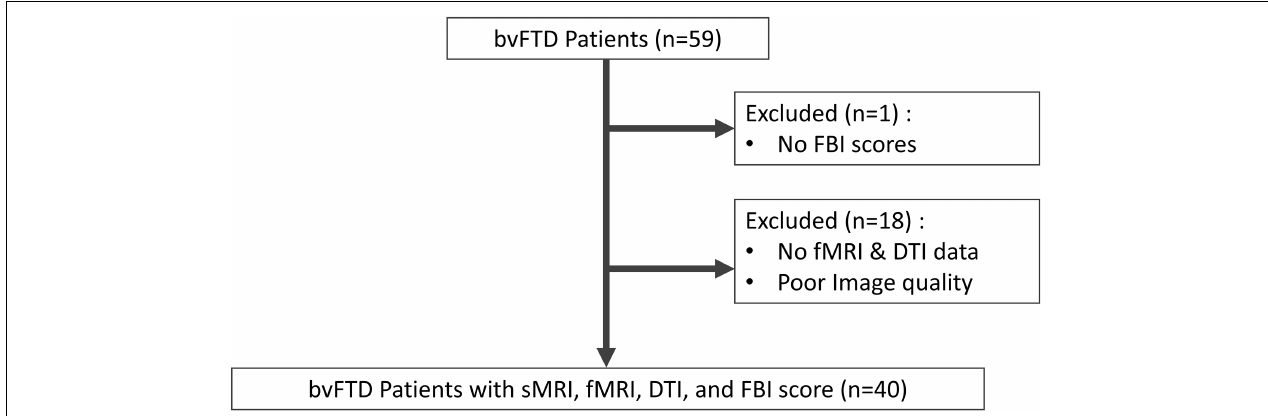
FIGURE 1 | Flowchart of the study participants and their enrolment. bvFTD, behavioral variant frontotemporal dementia; FBI, frontal behavioral inventory; fMRI, functional magnetic resonance imaging; DTI, diffusion tensor imaging; sMRI, structural magnetic resonance